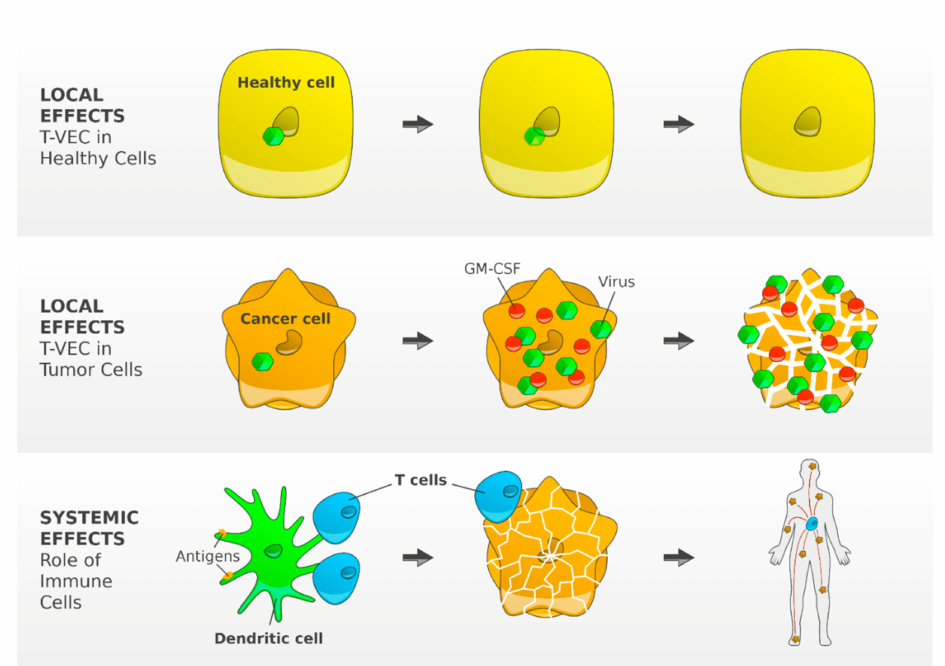
Figure 3. T-VEC—mechanism of action. T-VEC is a type 1 herpes simplex virus genetically modified